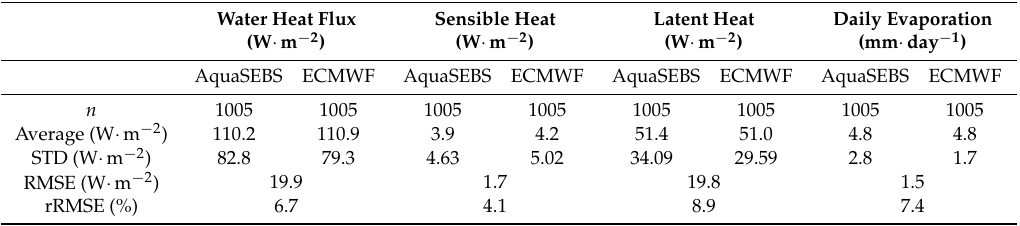
Table 4. Comparison between the AquaSEBS model and ECMWF model over Lake Victoria (January 2010 to September 2012).